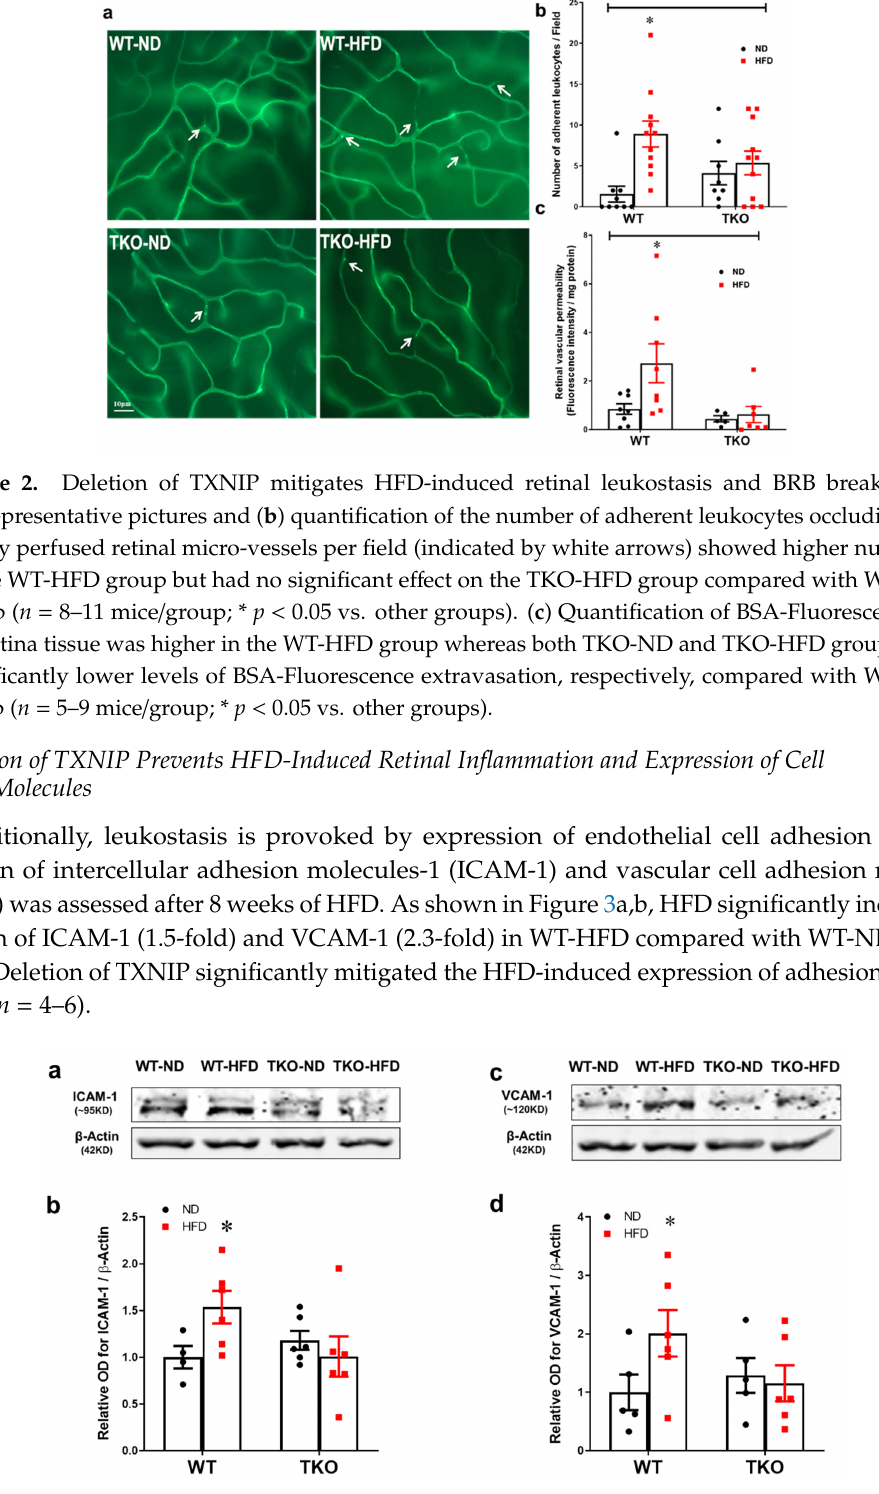
Figure 3. Deletion of TXNIP mitigates HFD-induced retinal expression of adhesion molecules. ( a , c ) Representative WB blots and statistical analyses of ( b ) ICAM-1 and ( d ) VCAM-1 showed increased expression of ICAM-1 and VCAM-1 levels in WT-HFD group compared with WT-ND group. In contrast, TKO mice groups showed no changes in response to HFD. Two-way ANOVA showed significant interaction between the type of diet and genotype across both ICAM-1 and VCAM-1 expression ( n = 4–6 mice/group; * p < 0.05 vs other groups).